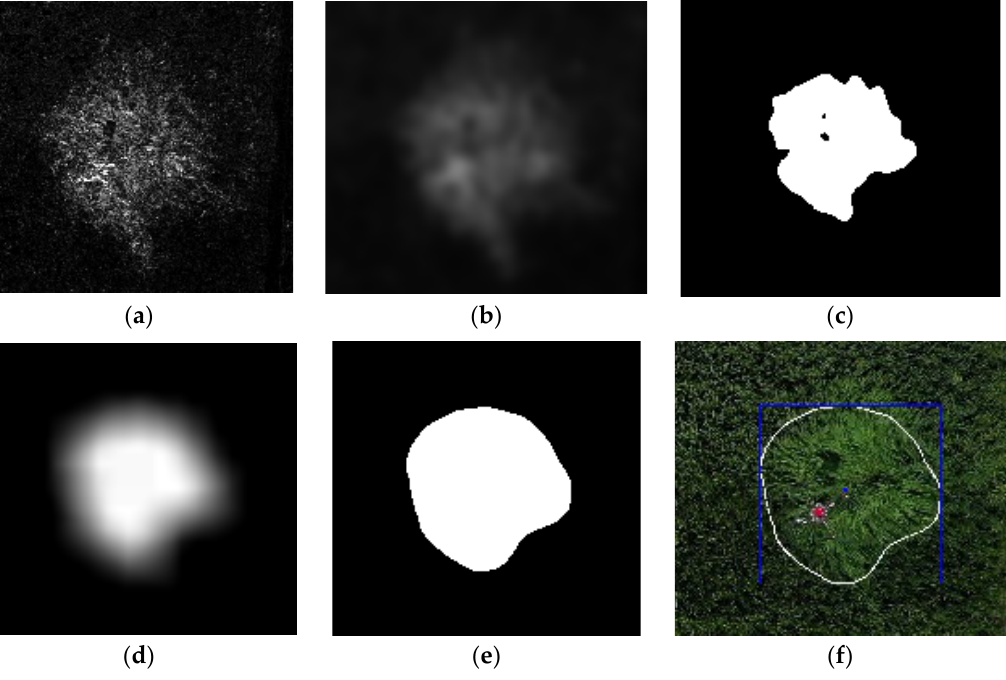
Figure 3. Identification of wind-vortex parameters. ( a ) Interframe difference. ( b ) Gaussian blur. ( c ) Binarization. ( d ) Mean blur. ( e ) Binarization. ( f ) Wind-vortex outline. Note: The identification steps of the wind vortex include ( a ) Interframe difference, ( b ) Gaussian blur, ( c ) Binarization, ( d ) Mean blur, ( e ) Binarization, and ( f ) generation of the wind-vortex contour.